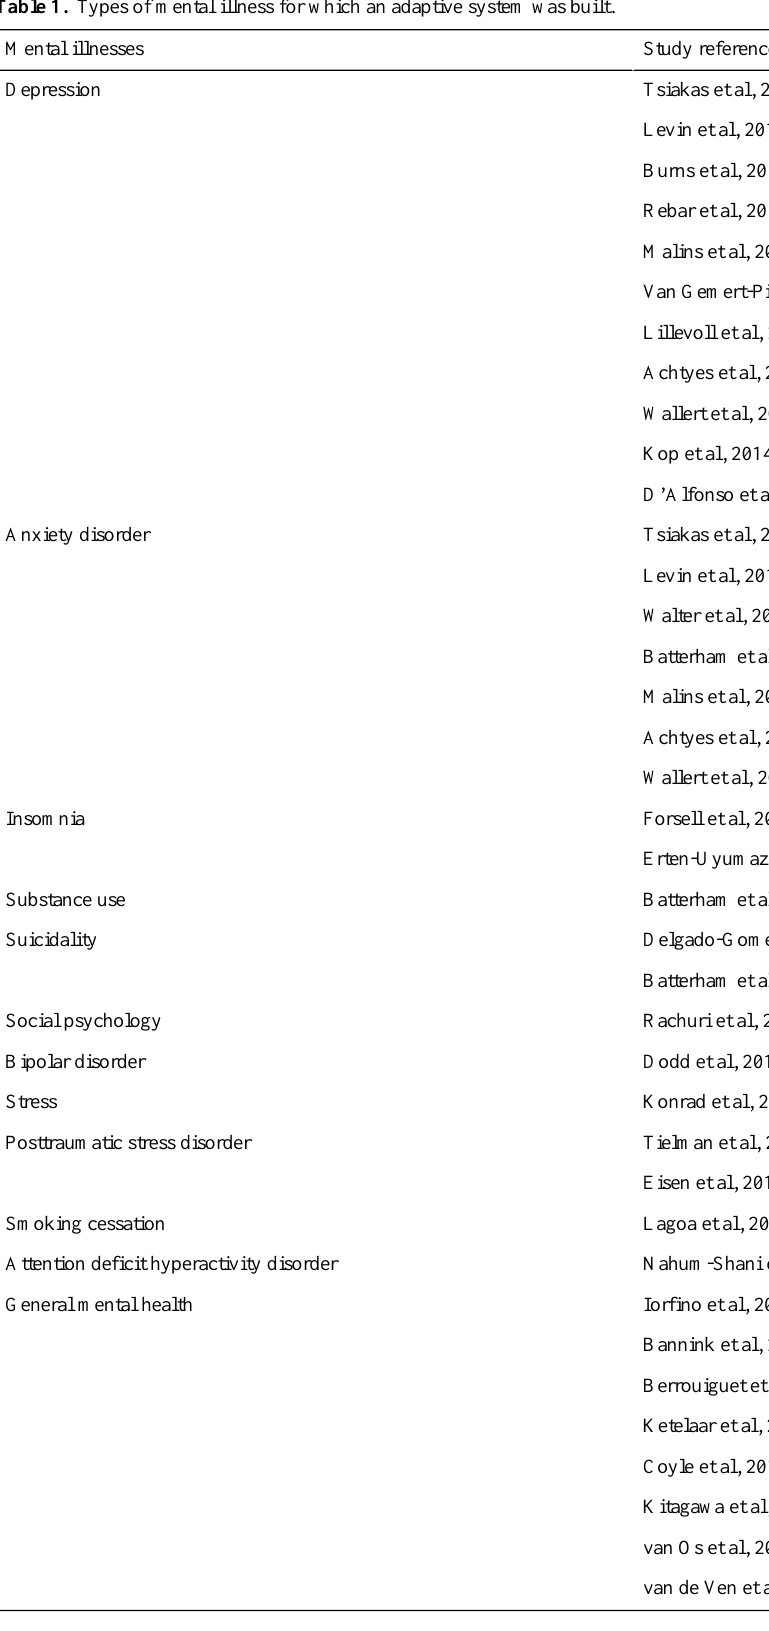
Table 1. Types of mental illness for which an adaptive system was